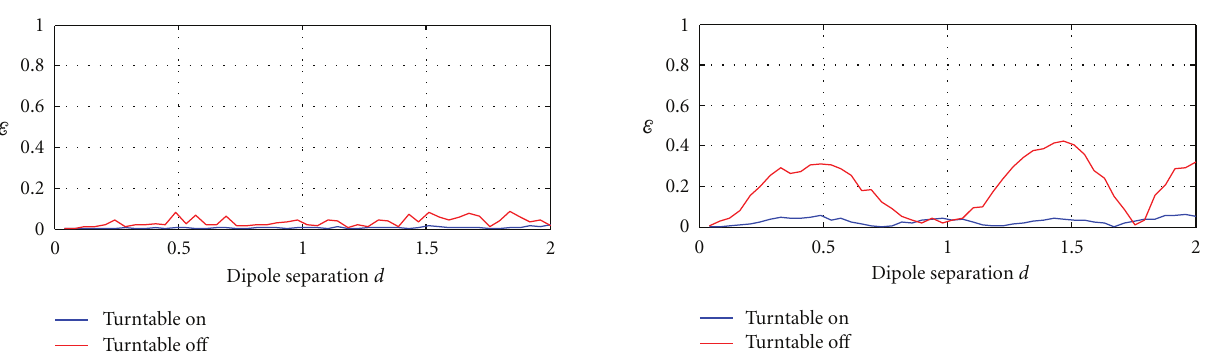
Figure 12: The error E as a function of dipole separation d for the large chamber with dimensions D x = 3m, D y = 2m, and D z = 1 . 5m operating around 750 MHz.